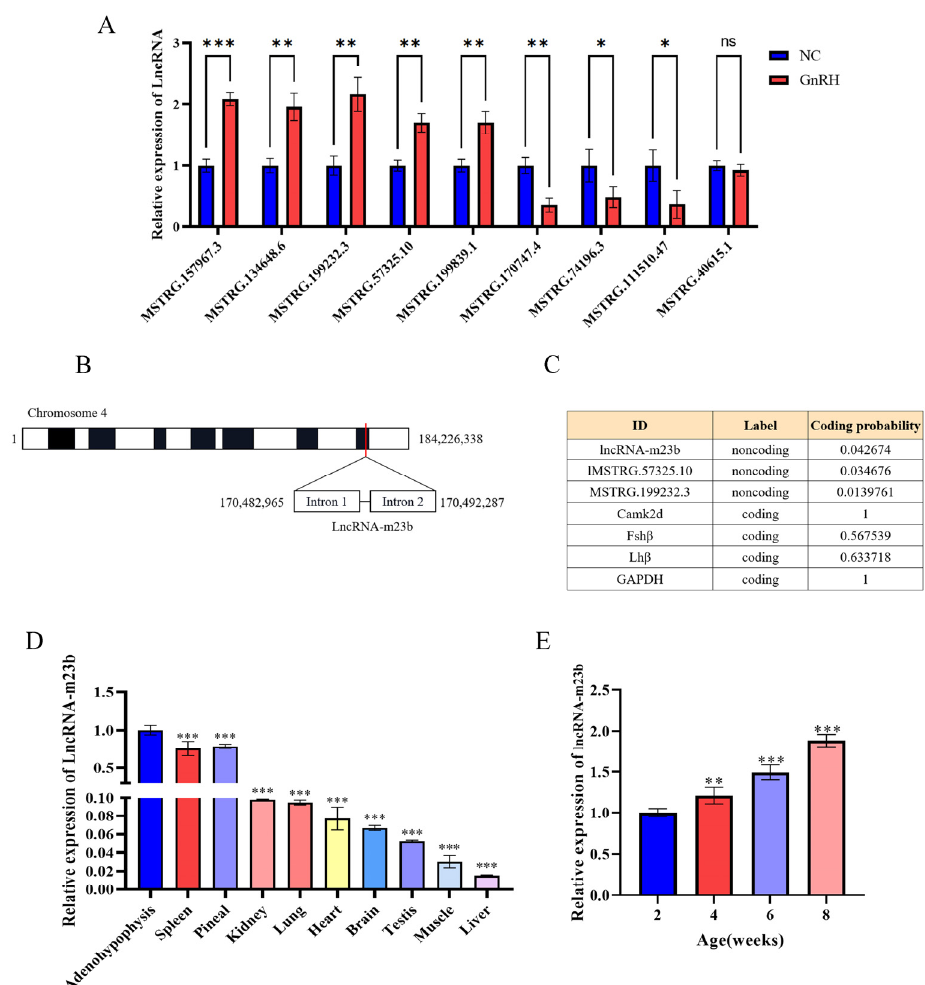
Figure 6. Identification of LncRNA-m23b. ( A ) Detection of differentially expressed lncRNAs by RT ‒ qPCR. ( B ) LncRNA-m23b chromosomal information. ( C ) Prediction of coding potential by CPC 2.0. ( D ) Expression of lncRNA-m23b in different tissues of male rats, lncRNA-m23b expression in the adenohypophysis was used as a control. ( E ) Expression of lncRNA-m23b in the adenohy- pophysis of rats at different developmental stages. ns, p > 0.05; *, p < 0.05; **, p < 0.01; ***, p < 0.001.